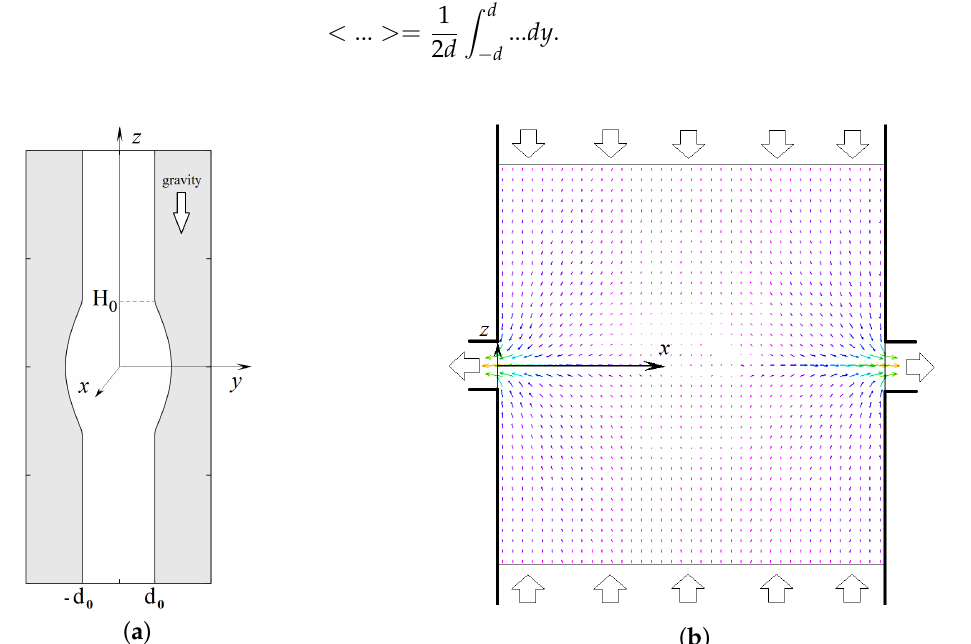
Figure 2. ( a ) Cross-section of the Hele-Shaw cell with a variable gapwidth and coordinate axes; ( b ) General scheme for supplying fresh reagents and withdrawing the reaction product in the continuous-flow microreactor. Solutions of acid and base come respectively from above and below, and the reaction product exits through the side